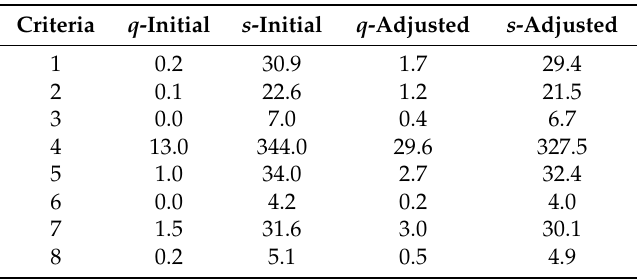
Table 10. Initial and adjusted parameters q and s .